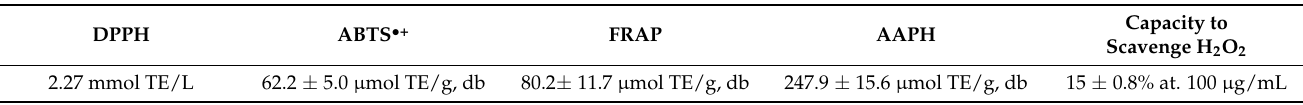
Table 3. TEAC (Trolox Equivalents Antioxidant Capacity) of OrP by different methods and its capacity to scavenge H 2 O 2 ; µ mol TE/g, db = µ mol of Trolox ® equivalents per gram of dry sample. Values are the means of three